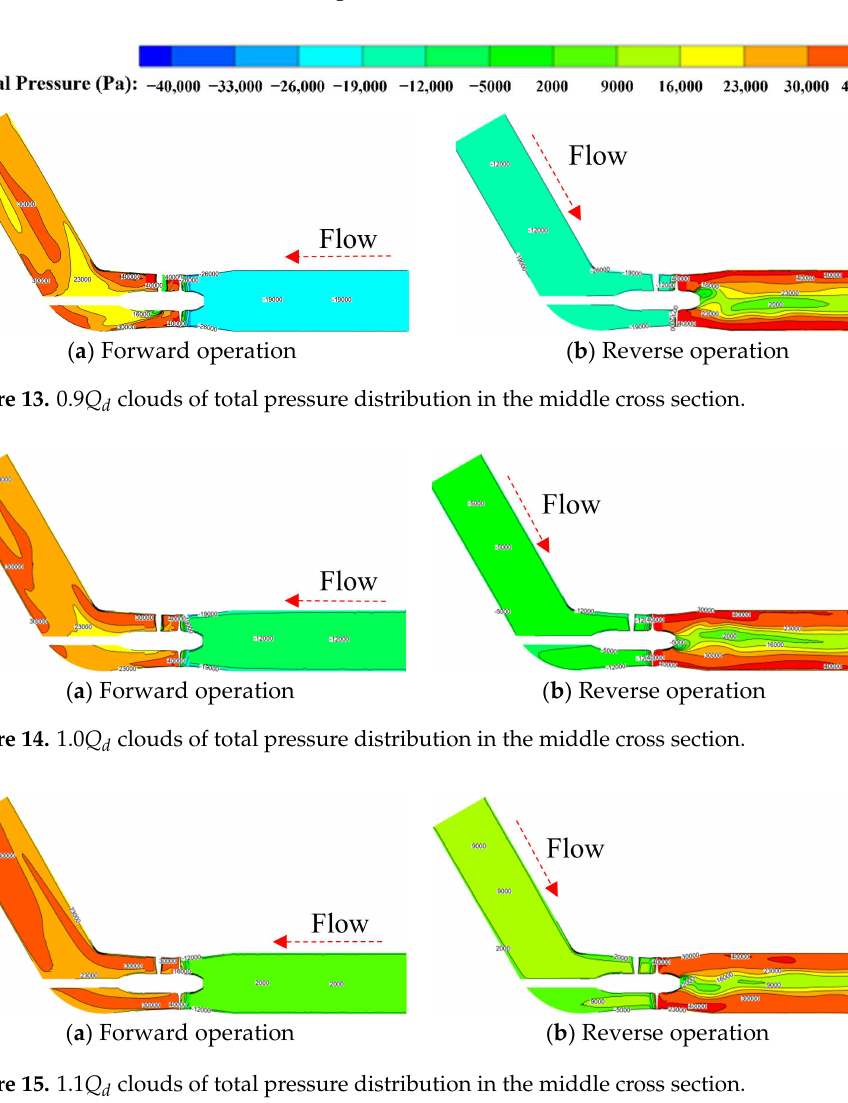
( b ) Reverse operation Figure 11. 1.0 Q d 3D streamline diagram.